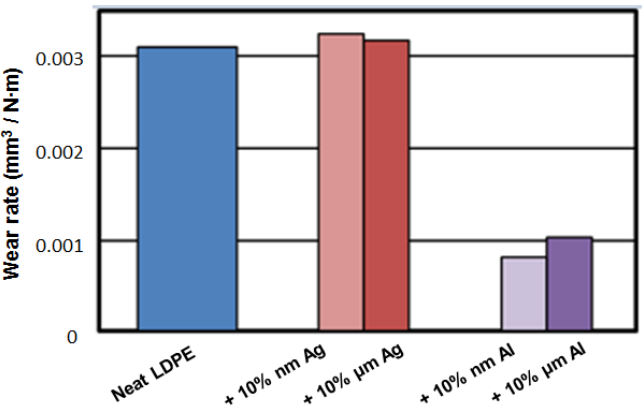
Figure 5. Wear rates for LDPE and its composites—containing nano- or micro- particles—against carbon nitride pin balls under the load of 7.0 N.